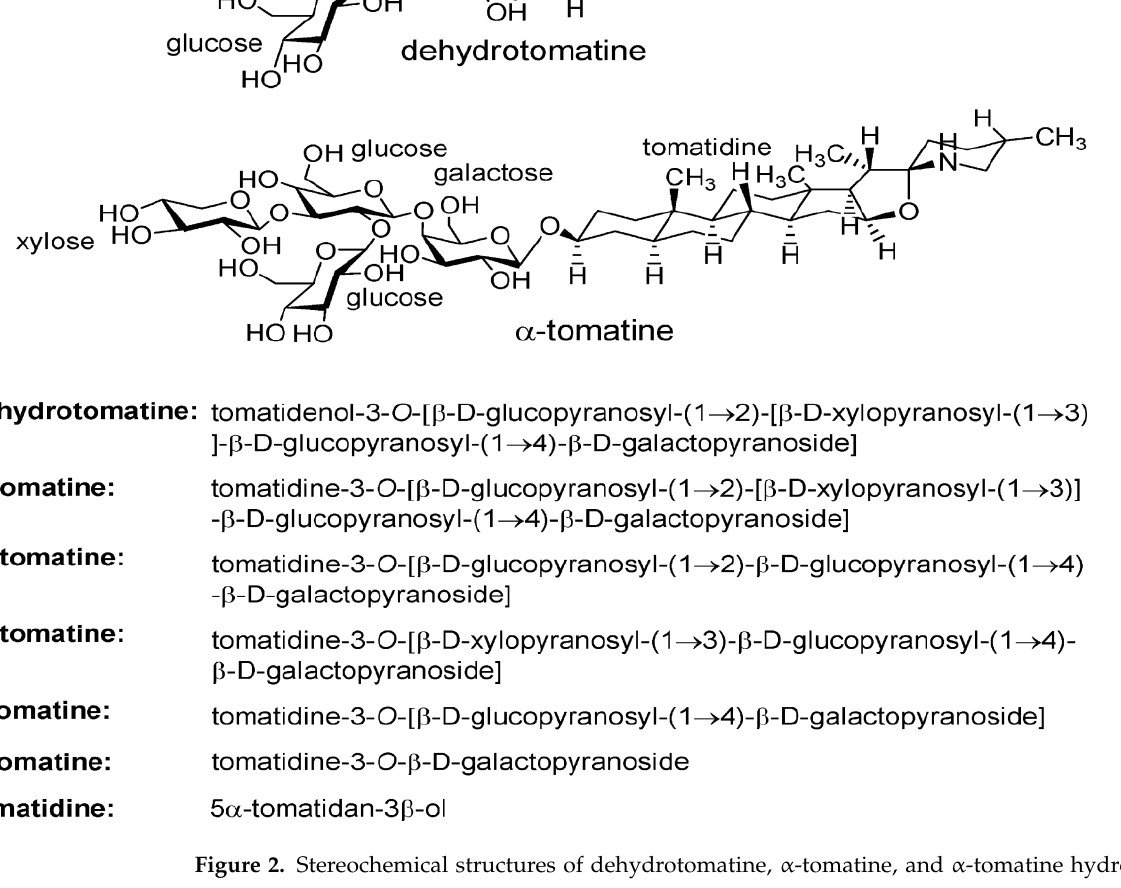
Figure 2. Stereochemical structures of dehydrotomatine, α-tomatine, and α-tomatine hydrolysis products. Molecular weights: dehydrotomatine (tetrasaccharide), 1032.2; α-tomatine (tetrasaccha- ride), 1034.2; β 1 -tomatine (trisaccharide), 902.05; β 2 -tomatine (trisaccharide), 872.03; γ-tomatine (disaccharide), 739.90; δ-tomatine (monosaccharide), 577.75; and tomatidine (aglycone), 415.66. The stereochemical chemical names were adapted from [13,14].